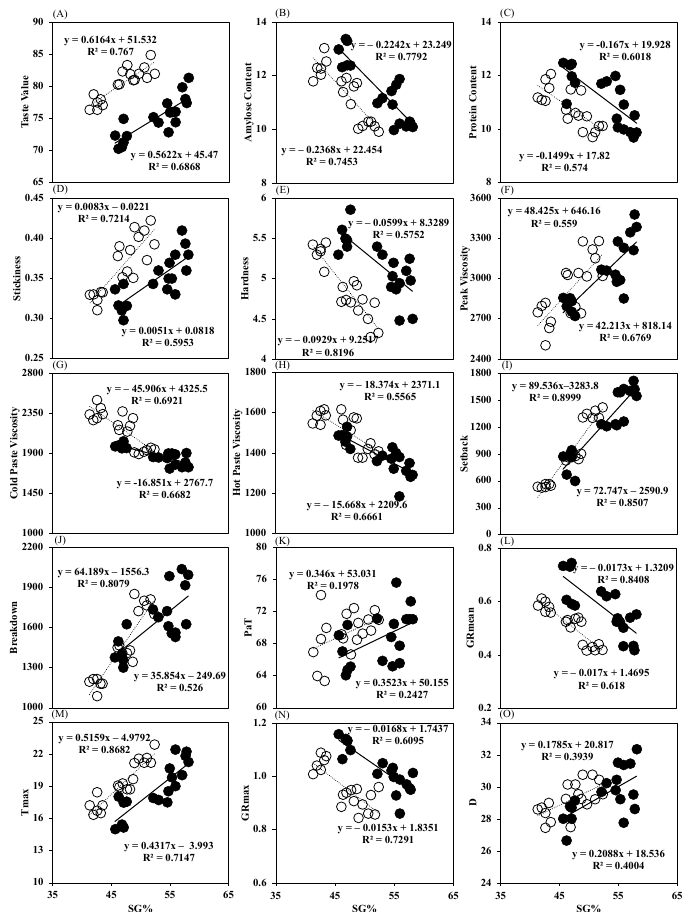
Figure 7. Relationship between physiochemical properties, texture properties, RVA profiles and filling characteristics with ratio of grains located in secondary branches (SG%). ( A – E ): Cooking and taste quality; ( F – K ): RVA parameters; ( L – O ): grain filling parameters. Note: Black dots represented the performance of N7 and white dots represented the performance of N9108.